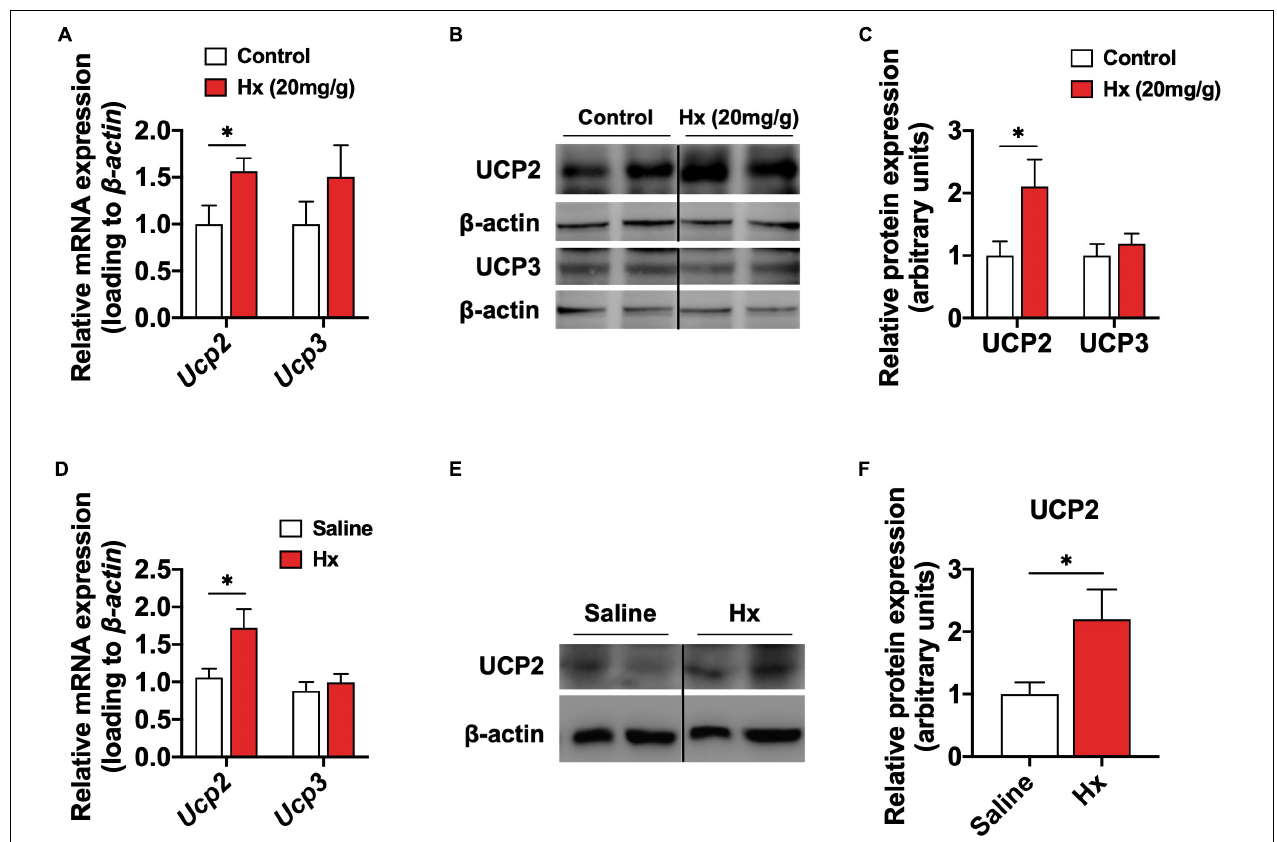
FIGURE 5 | Hx induces the activation of UCP2 in skeletal muscle. (A) mRNA expression of UCP2 and UCP3 in the GAS muscle after 4 weeks Hx treatment ( n = 8 mice per group). (B,C) Western blot (B) and quantification (C) of UCP2 and UCP3 content in the GAS muscle after 4 weeks Hx treatment ( n = 6 per group). Dividing lines indicate spliced bands from the same gel. (D) mRNA expression of UCP2 and UCP3 in the GAS muscle after acute Hx treatment ( n = 8 mice per group). (E,F) Western blot (E) and quantification (F) of UCP2 content in the GAS muscle after acute Hx treatment ( n = 6 per group). Dividing lines indicate spliced bands from the same gel. β -actin was used as loading control both in qRT-PCR and western blot. Values are presented as means ± SEM. ∗ P ≤ 0.05 according to the non-paired Student’s t -test between individual